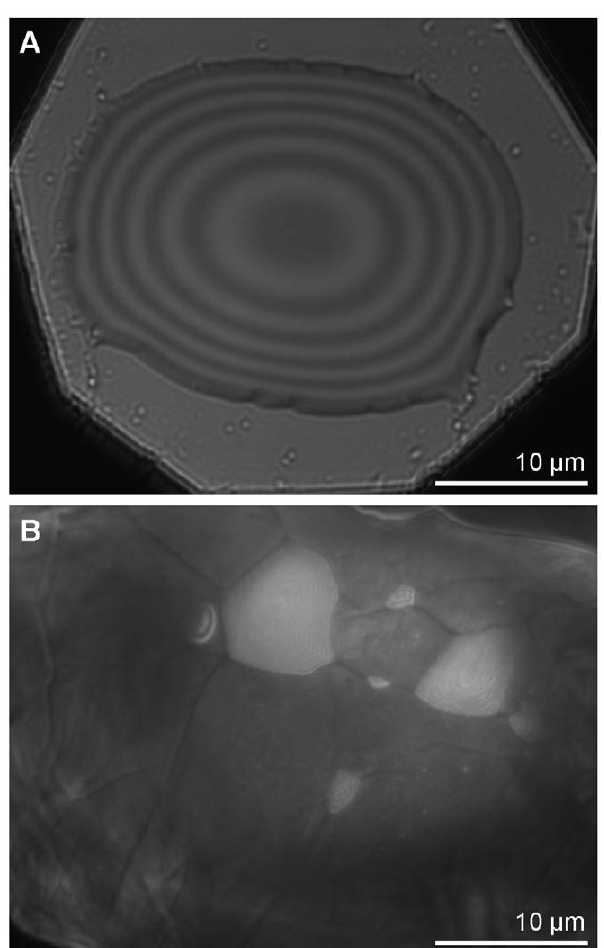
Figure 3. Grammostola setae at various stages of wetting. (A) Little or no fluid has accumulated underneath setae, and individual spatulae are still visible. (B) Small fluid droplets, appearing here as dark areas, bridge the gaps between spatulae. (C) A continuous fluid layer forms underneath each seta. (D) Fluid accumulates, bridging gaps between setae. See Video S4 for complete footage.